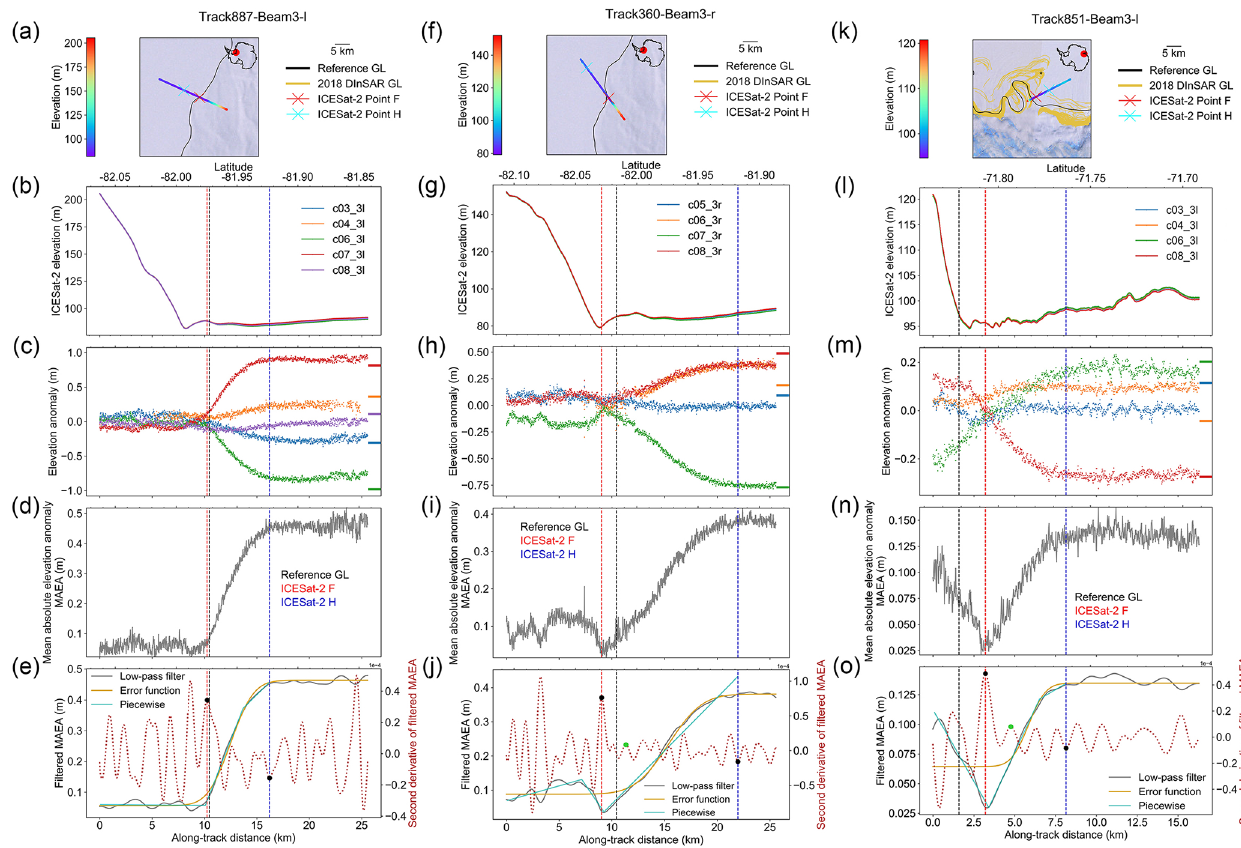
Figure 3. Examples of repeat-track analysis for track 887 (a–e) and track 360 (f–j) on the Filchner–Ronne Ice Shelf and track 851 (k–o) on the Amery Ice Shelf. (a, f, k) The locations of ICESat-2-derived inland limit of tidal flexure Point F (red cross) and the inland limit of hydrostatic equilibrium Point H (cyan cross), along with the reference elevation of the nominal reference track (colour-coded), the composite grounding line (GL) (black line) used to calculate the reference GL in the repeat-track analysis, and the DInSAR-derived Point F in 2018 (yellow line) (Mohajerani et al., 2021). All data are overlaid on the Landsat Image Mosaic of Antarctica (Bindschadler et al., 2008). (b, g, l) ICESat-2 “re-tided” elevation profiles. (c, h, m) The elevation anomalies of all repeat tracks inside each repeat-track data group. The horizontal lines at the right are the zero mean tide height predictions from the CATS2008 tidal model (Padman et al., 2002). (d, i, n) The mean absolute elevation anomaly (MAEA). (e, j, o) Low-pass-filtered MAEA is shown as a solid grey line; error function fitting of the MAEA is shown as a solid yellow line, the three-segment piecewise function fitting of the landward part of the Point H of the MAEA is shown as a solid green line; the second derivative of low-pass-filtered MAEA is shown as a dotted maroon line; the piecewise-function-derived Point F is shown as the black dot on the left; the wrong Point F picks from error function fitting are shown as the green dots in (j) and (o) ; Point H is shown as the black dot on the right of each panel. Locations of Point F, Point H, and the reference GL are marked as the vertical dashed red line, vertical dashed blue line, and vertical dashed black line in all panels apart from (a) , (f) , and (k)